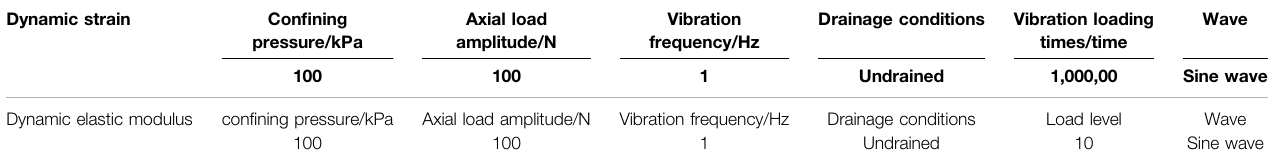
TABLE 1 | Test control conditions.